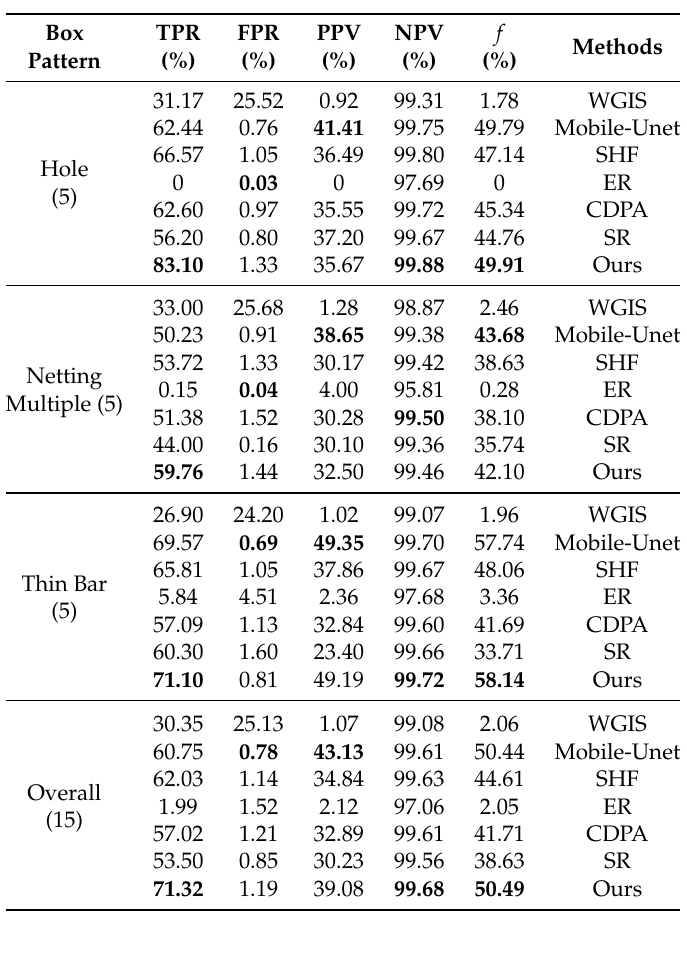
Table 2. Numerical results of each defect type for box-patterned fabric.